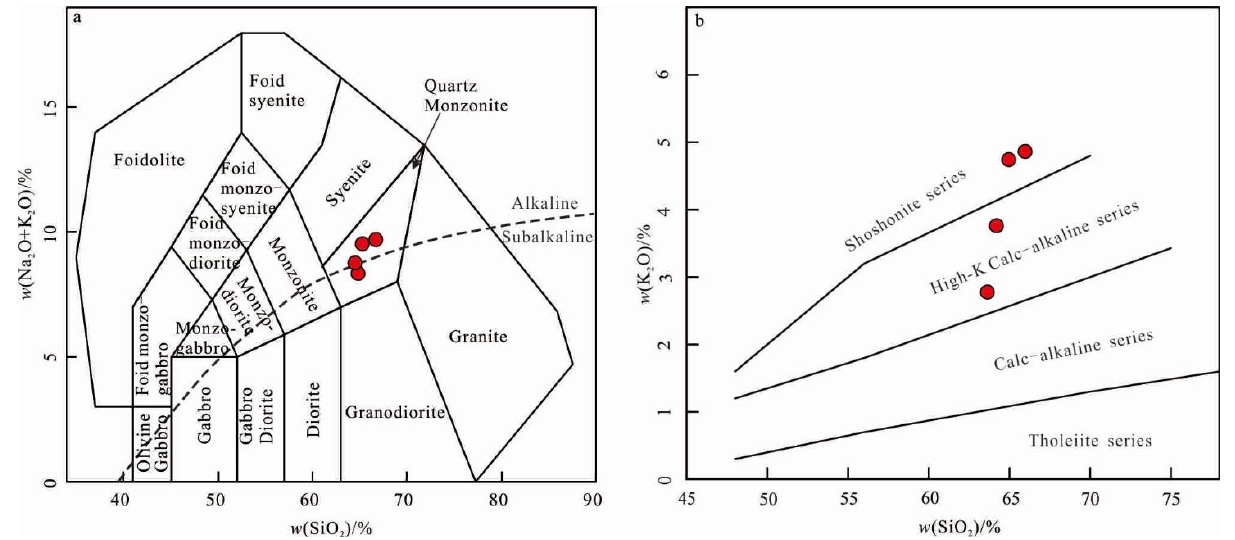
Figure 4. TAS (( a ), modified after reference [20]) and SiO 2 － K 2 O (( b ), modified after reference [21]) diagrams of quartz monzonites from the Jinling area, the western Shandong province.